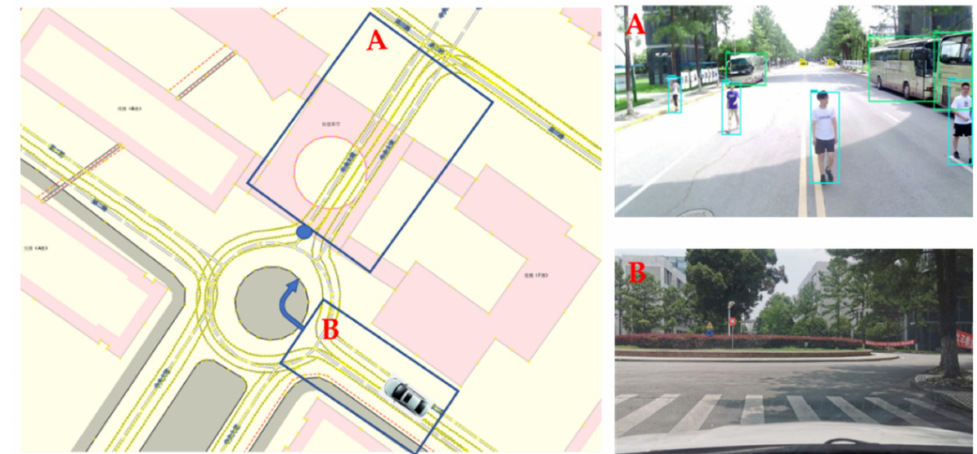
Figure 18. Test scenario for the vehicle-to-infrastructure (V2I) system. The left side is a HD map in vector format from OpenStreetMap. The blue marker is the placement of the roadside unit (RSU).